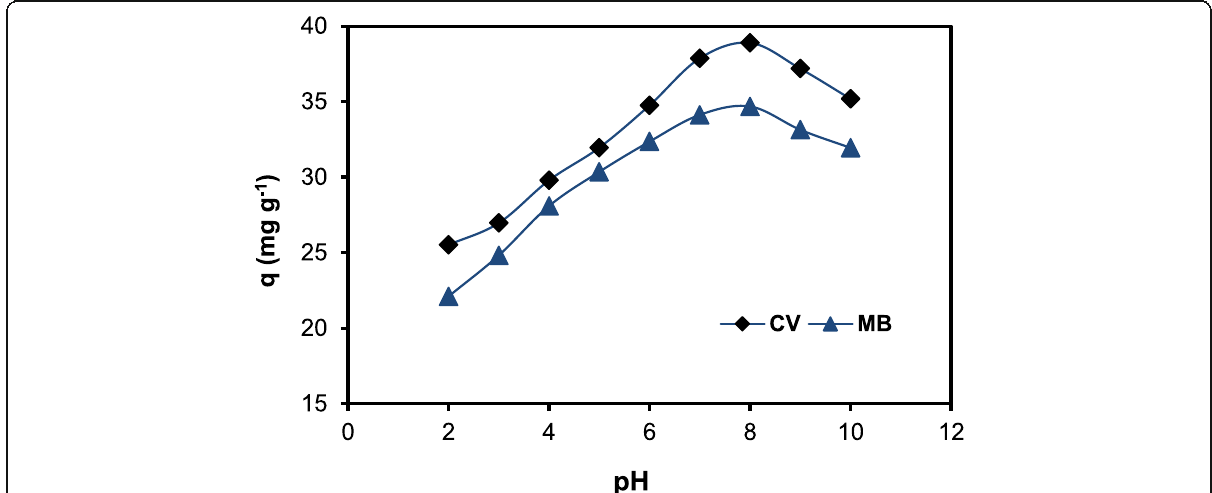
Fig. 4 Effect of the solution pH on the adsorption of CV and MB dyes by the ASS adsorbent (adsorbent dose of 50 mg, volume of adsorbate of 20 mL, contact times of 60 min, and temperature of 27